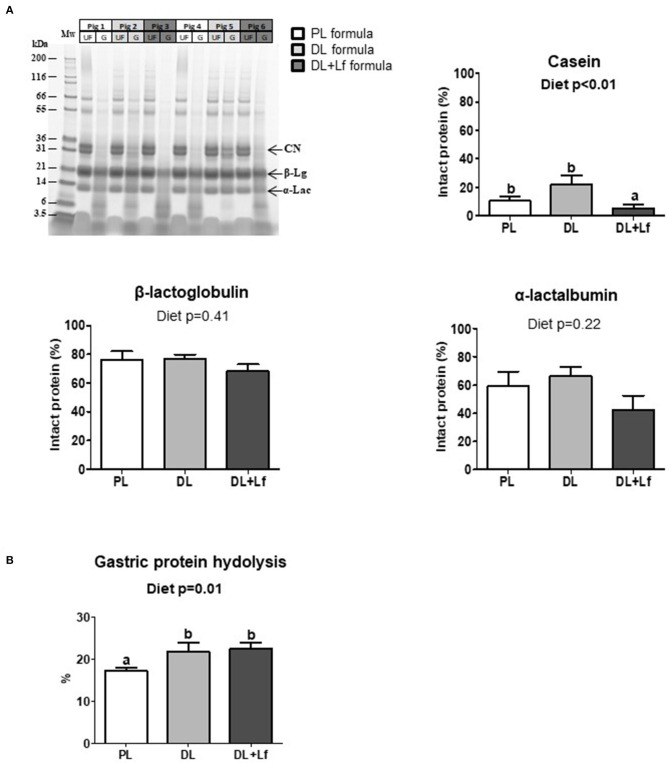
Gastric proteolysis of PL, DL, and DL+Lf formulas. (A) Example of SDS-PAGE protein profiles of PL, DL, and DL+Lf formulas during gastric in vivo digestion. Protein molecular mass standards (Mw) are on the left followed by the undigested infant formula (UF) and corresponding gastric content (G) for the same pig (side by side). Gastric proteolysis resistance: corresponding percentage of intact proteins [casein (CN), β-lactoglobulin (β-Lg), and α-lactalbumin (α-Lac)] during gastric digestion, estimated by densitometry in comparison to the corresponding undigested formula. Data are expressed as the mean ± SEM. Labeled means without a common letter differ (p < 0.05). (B) Gastric proteolysis evaluated by NH2 quantification. Formulas contained as lipids either only plant lipids (PL, n = 7–8), a half-half mixture of plant and dairy lipids (DL, n = 6–8), or a half-half mixture of plant and dairy lipids supplemented with Lf (DL+Lf, n = 6). SDS-PAGE, sodium dodecyl sulfate–polyacrylamide gel electrophoresis; CN, casein; β-Lg, β-lactoglobulin; α-Lac, α-lactalbumin.